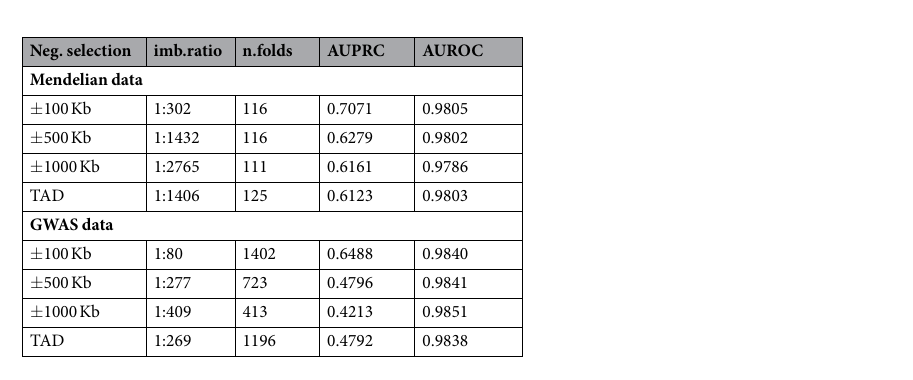
Table 1. Performance of hyperSMURF with different selection strategies for negatives. The first column represents the size of the “genomic window” used to select negatives around each positive or the “TAD-based” negative selection strategy; the second column reports the imbalance between positive and negative examples; the third the number of folds of the “topologically-aware” cross-validation, while the last two columns show the estimated AUPRC and